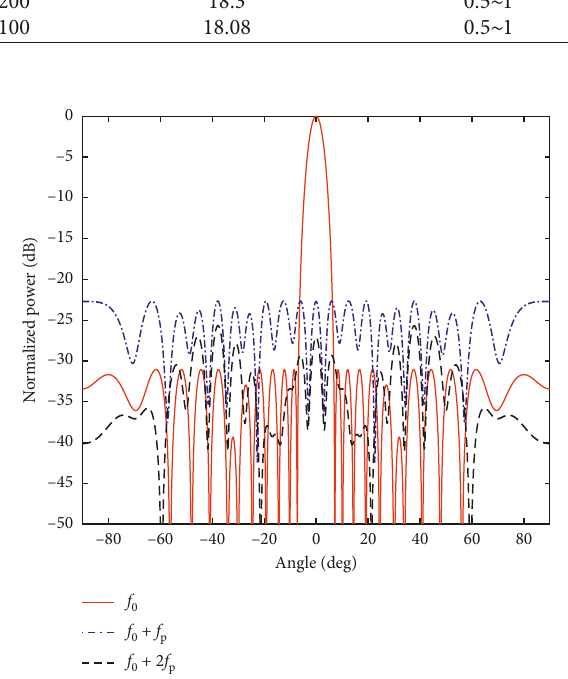
Figure 11: In-phase excitation pattern of using the PSO-CVX algorithm in the PS